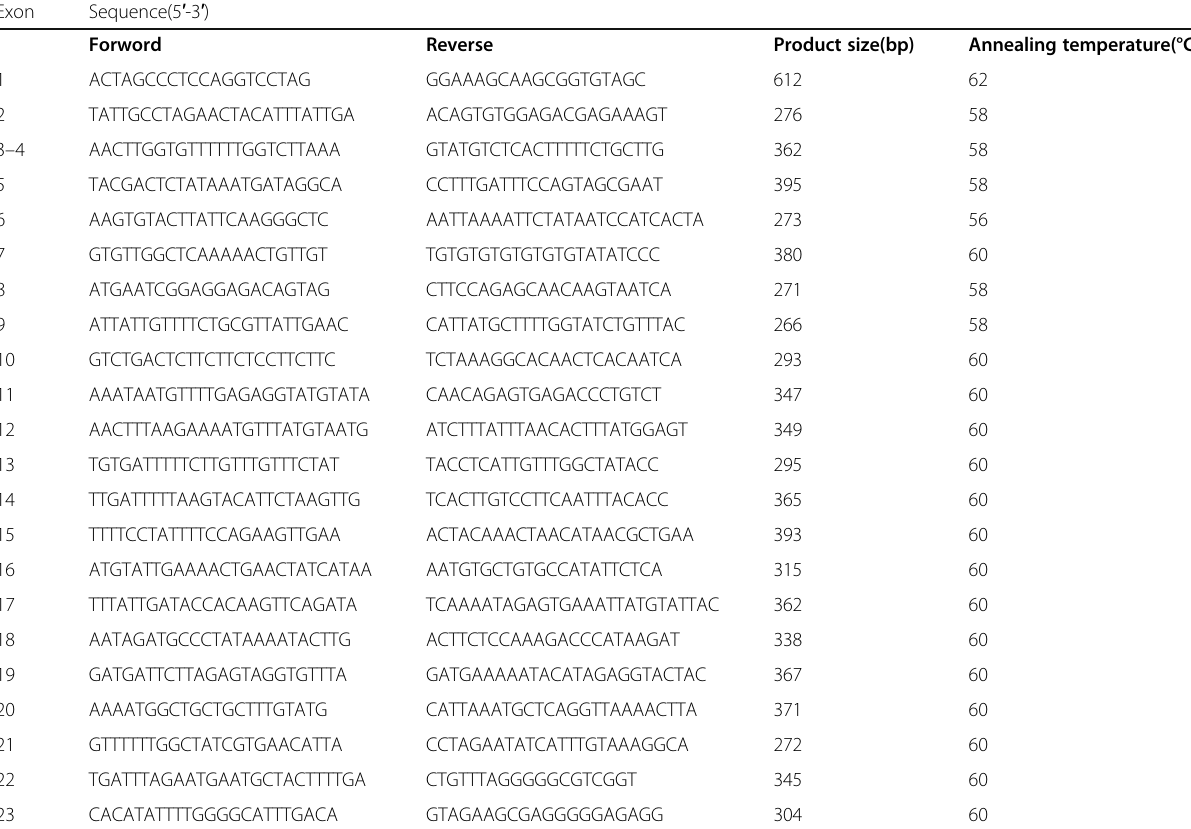
Table 2 PCR primers and conditions used for mutation analysis of the PCCA gene Exon Sequence(5 ′ -3 ′